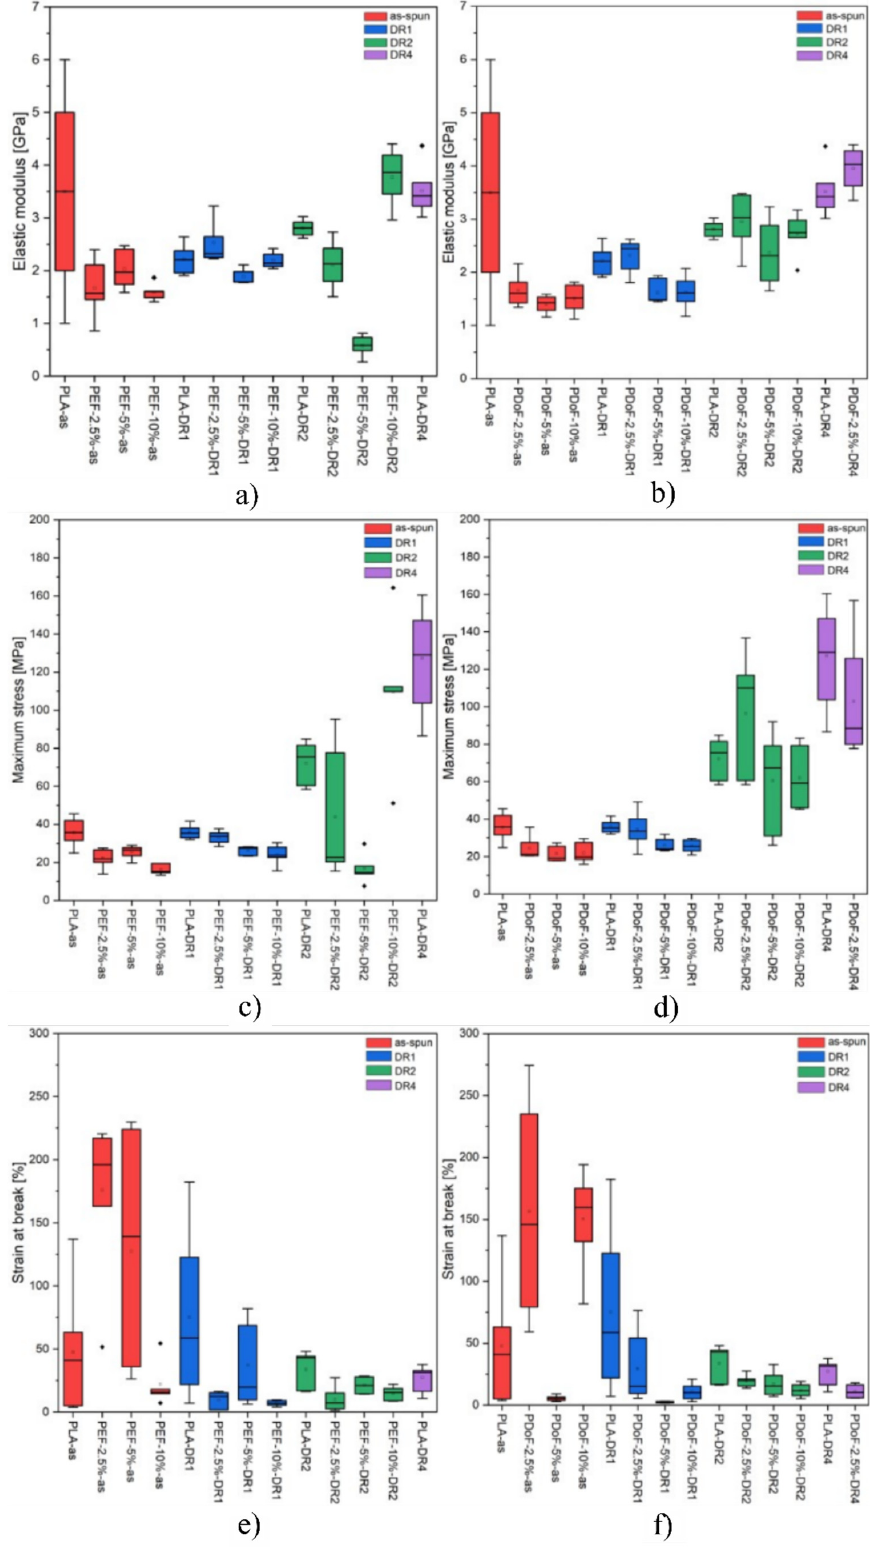
Figure 11. Boxplot of the samples grouped according to the composition and the drawing process: elastic modulus of ( a ) PLA/PEF and ( b ) PLA/PDoF fiber blends, maximum stress of ( c ) PLA/PEF and ( d ) PLA/PDoF fiber blends, strain at break and of ( e ) PLA/PEF and ( f ) PLA/PDoF fiber blends.